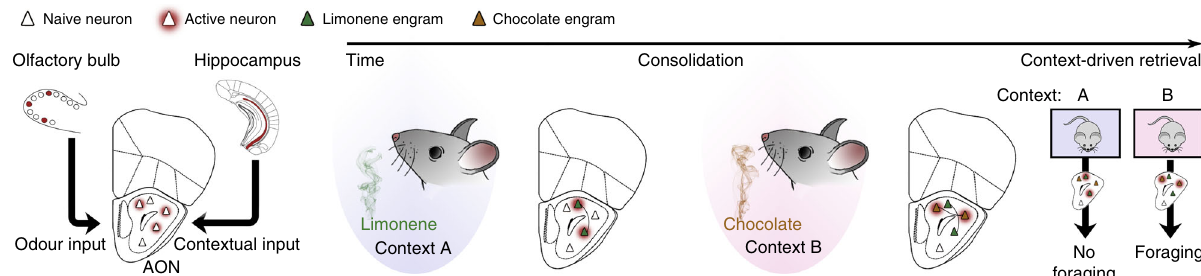
Fig. 4 Odour engrams are stored in the AON. A model diagram depicting the formation, storage and retrieval of unique, contextually-relevant odour engrams within the